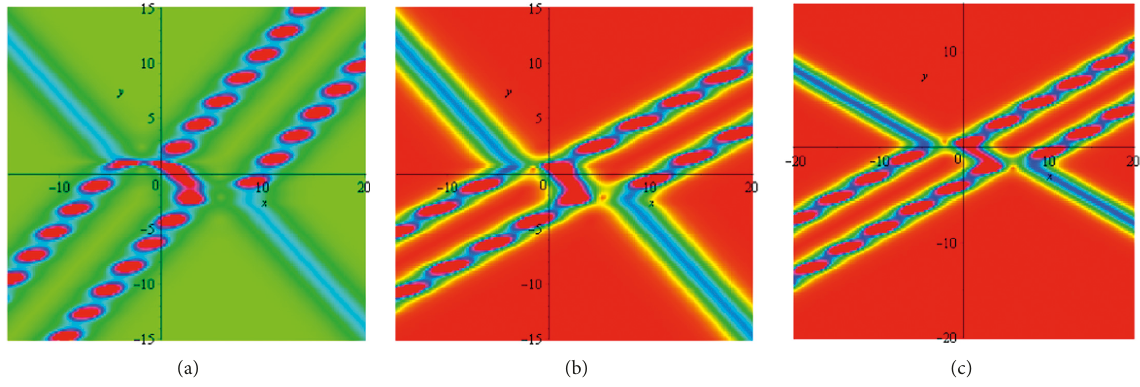
Figure 13: Plots of equation (67) by using c